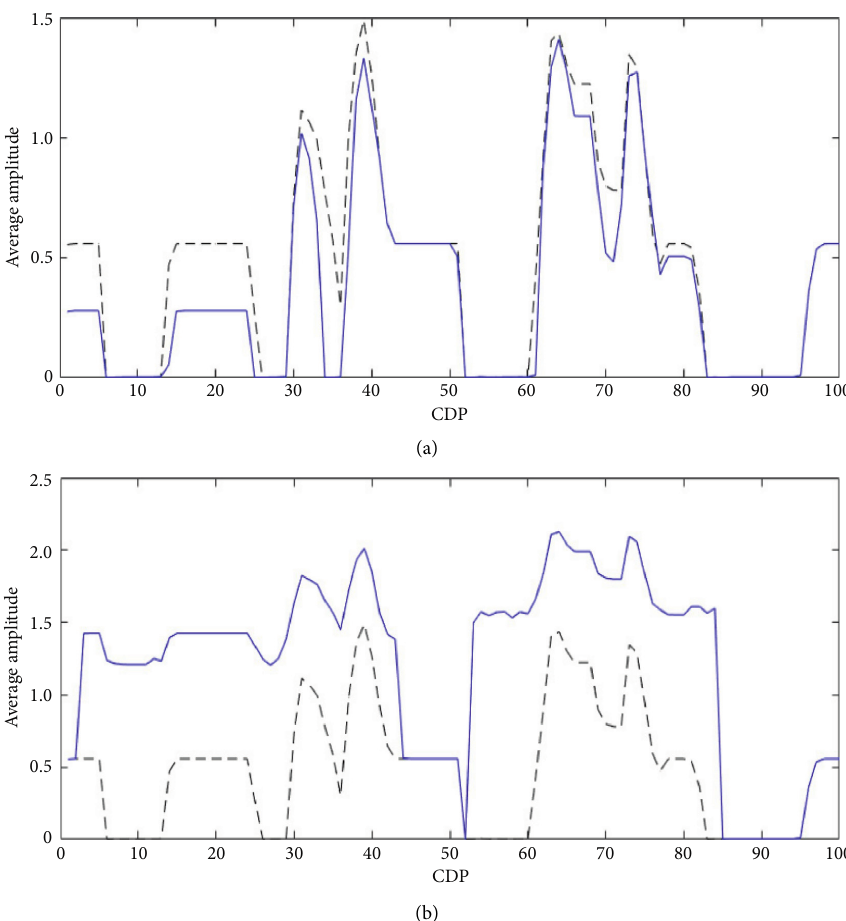
Figure 11: Contrast diagram of the average amplitude extracted from the synthetic seismic records of channel reservoir with and without interference at 20Hz. (a) Noninterference and upper interference. (b) Noninterference and lower